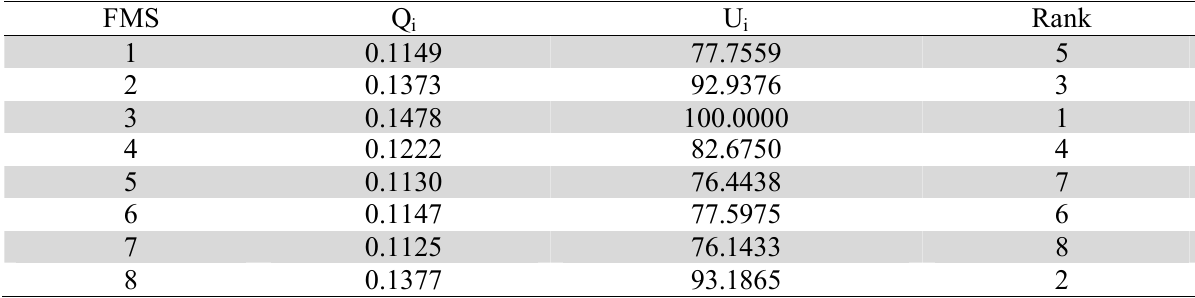
and U values in COPRAS Q i i